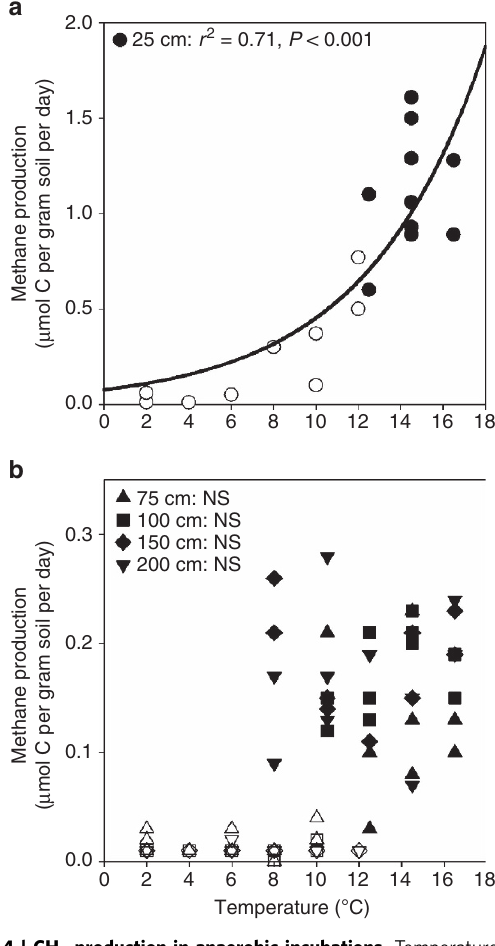
Figure 4 | CH 4 production in anaerobic incubations. Temperature response of CH 4 production from ( a ) surface and ( b ) deep peat samples that were anaerobically incubated within 1 (cid:2) C of in situ temperatures after B 4 (closed symbols, September 2014) and 13 (open symbols, June 2015) months of deep peat warming. Circles represent values from 25cm, triangles represent results from 75cm, squares represent results from 100cm, diamonds represent results from 150cm and inverted triangles represent results from 200cm. Temperatures reflected in situ temperatures at time of collection. The temperature response of deep peat ( b ) for each season was analysed separately due to a distinct bimodal distribution. Dark line indicates significant regression results. NS, not